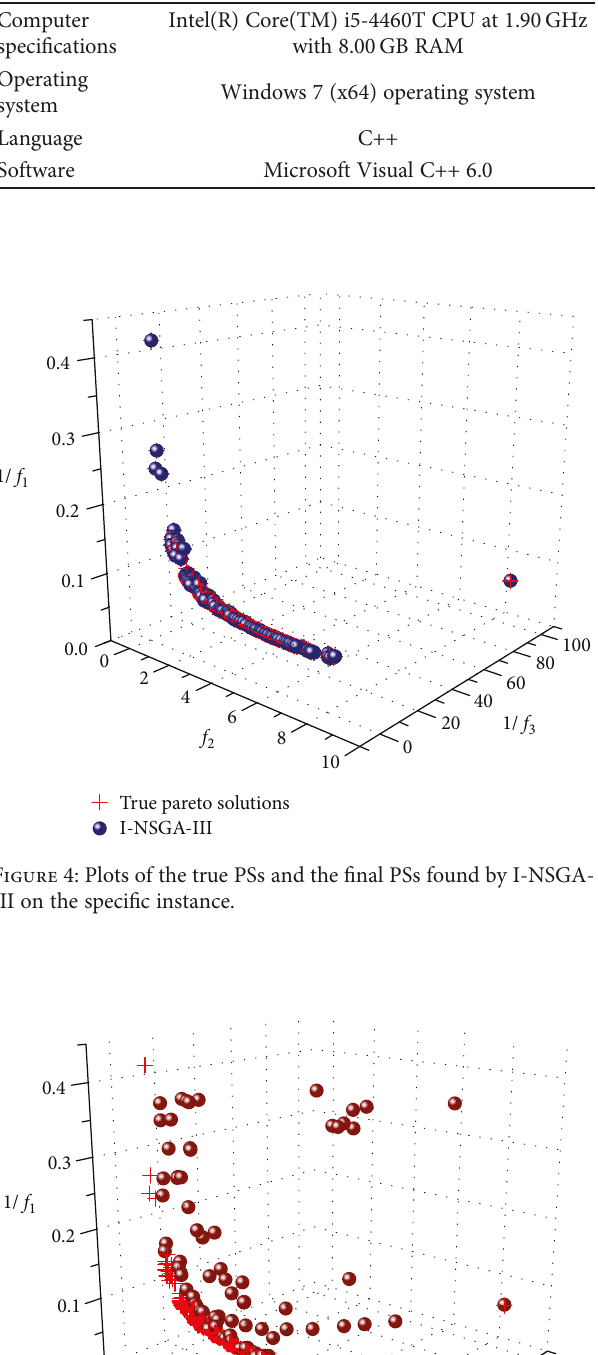
Table 15: Parameters of simulation environment.